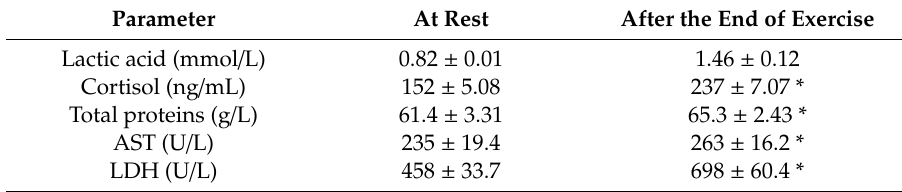
Table 4. Biochemical parameters determined in studied endurance horses (lsm ±